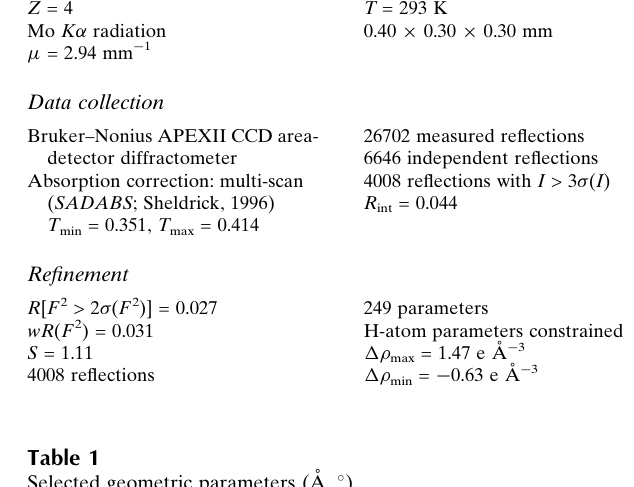
Selected geometric parameters (A˚ , (cid:2)